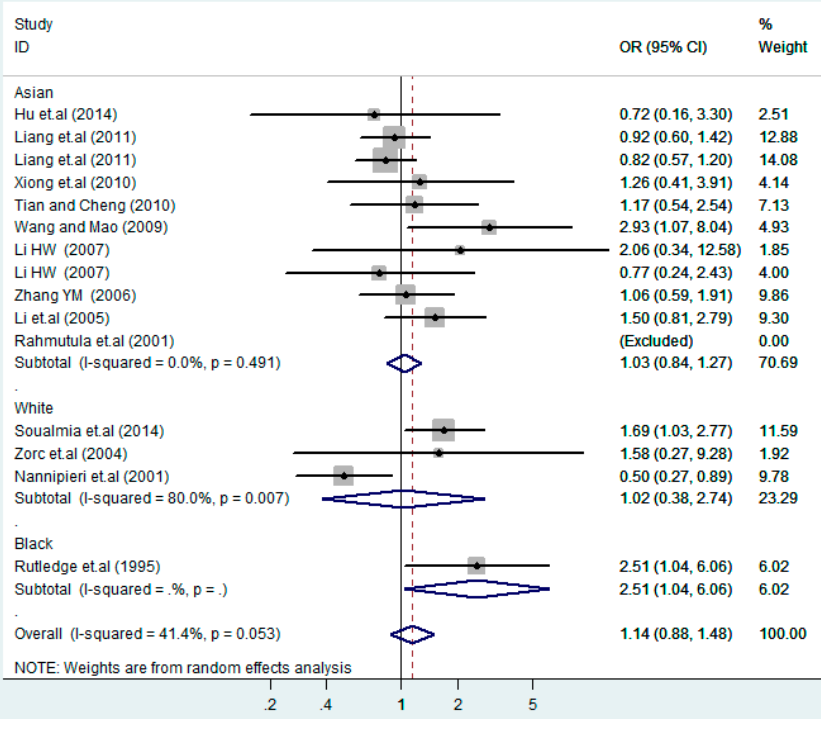
Figure 10. Ethnic subgroups analysis of T2238C co-dominant model-1 (TC vs. TT).